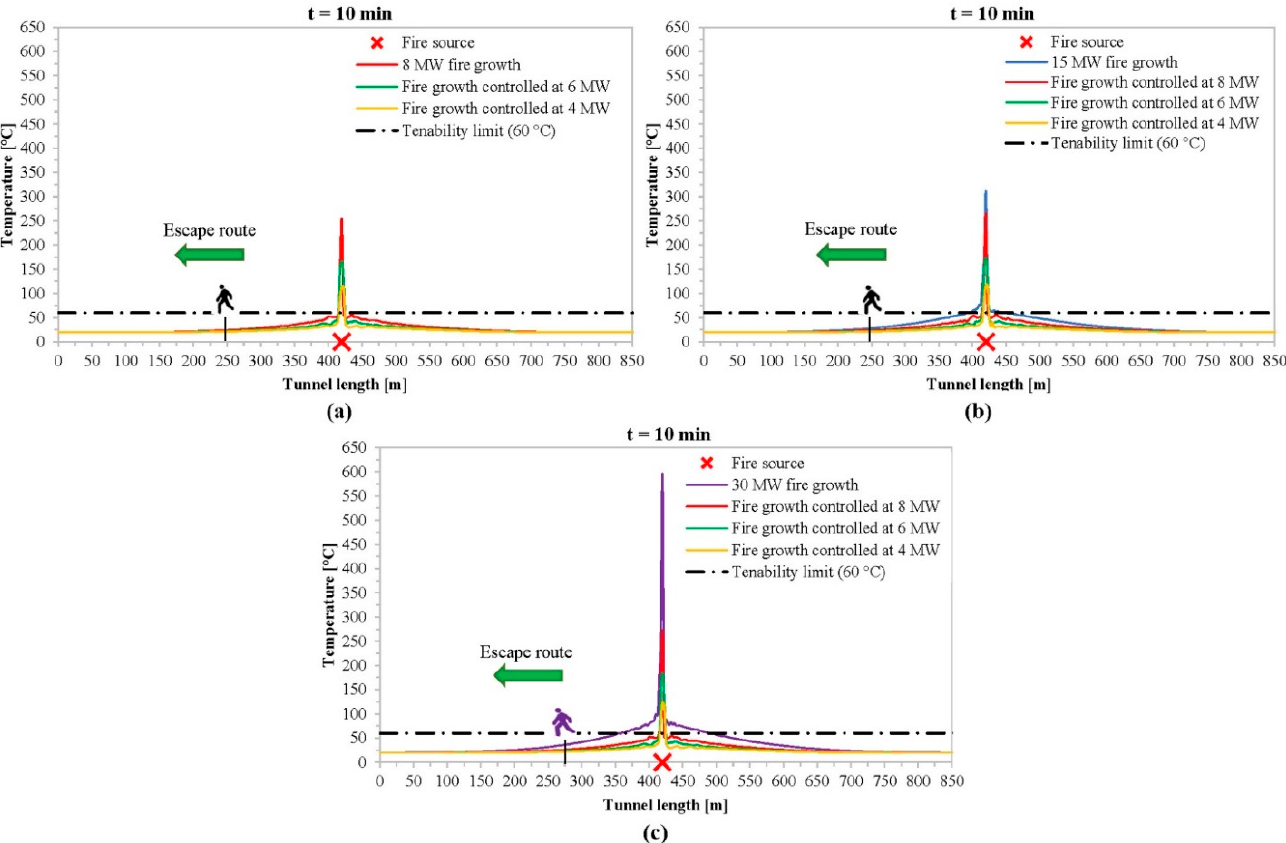
Figure 11. Profiles of longitudinal temperature at a height of 2 m along the escape route on the road carriageway after 10 min from the fire’s start when the burning vehicle is at 420 m from portal A and the micronized water system is activated before that the fire growth achieves values of: ( a ) HRR max = 8 MW, ( b ) HRR max = 15 MW, ( c ) HRR max = 30 MW.